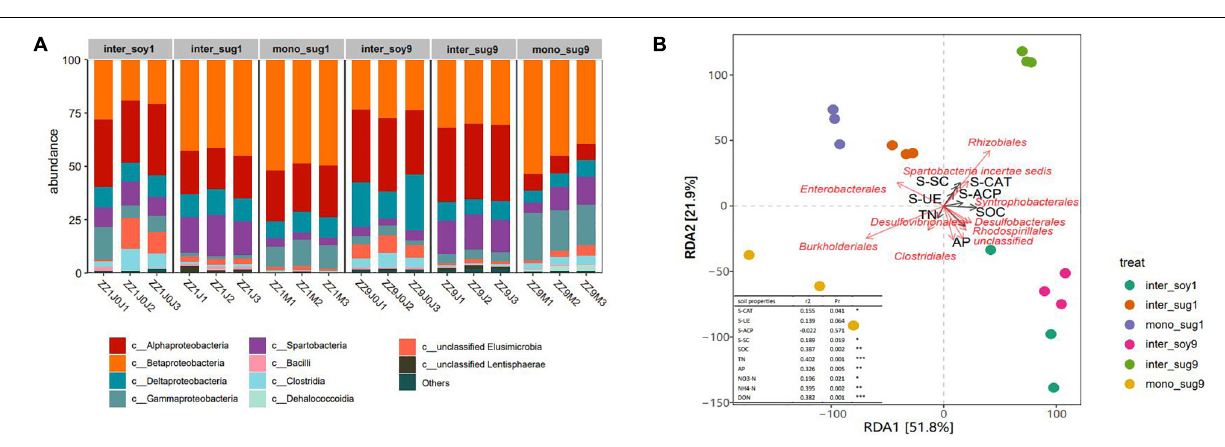
showed that, in the ZZ1–soybean intercropping system, the numbers of ASVs contained in M1, M2, and M3 modules were not high, with Alphaproteobacteria being dominant in M1